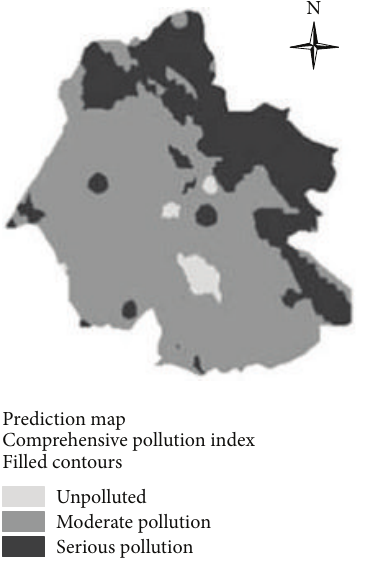
Figure 6: Distribution maps of comprehensive pollution